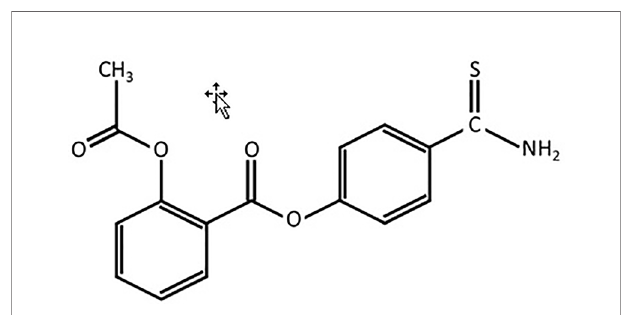
FIGURE 1 | Chemical structure of 4-(5-thioxo-5H-1,2-dithiol-3-yl)phenyl 2- acetoxybenzoate(l) — H 2 S-releasing